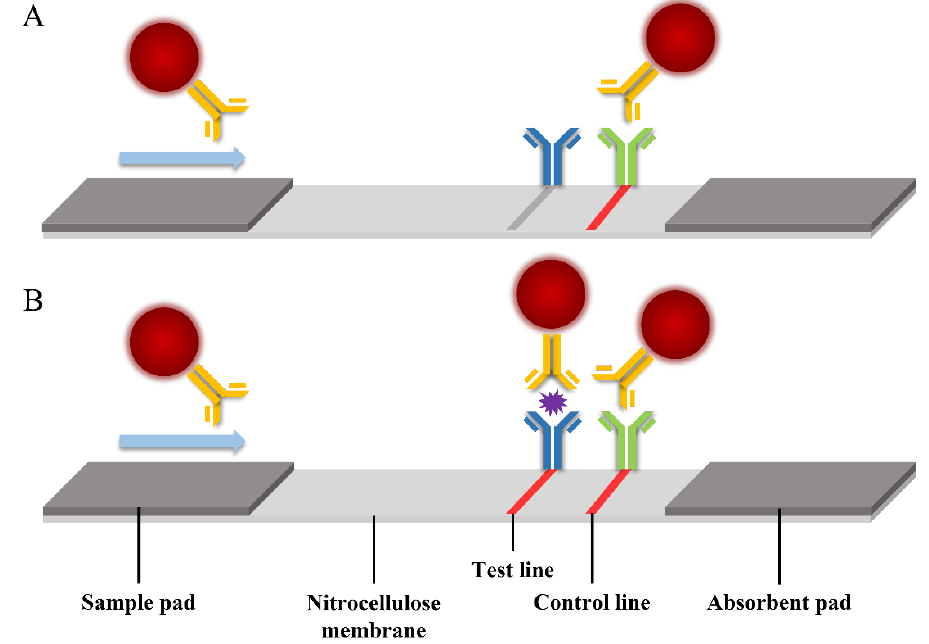
Figure 1. Analytical representation of the immunoassay strip. ( A ) If the sample does not contain COVID-19 N protein, there is no fluorescent signal at the test line ( B ) If the sample contains N protein, there is a bright fluorescent signal at the test line.